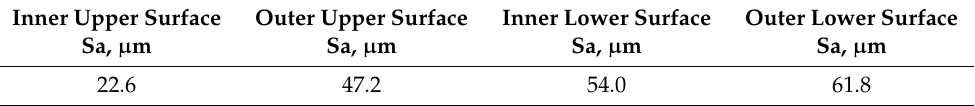
Figure 5. A picture of the upper wing surface in the vicinity of the root. Table 4. Surface roughness of the wing model at different locations. Table 4. Surface roughness of the wing model at different